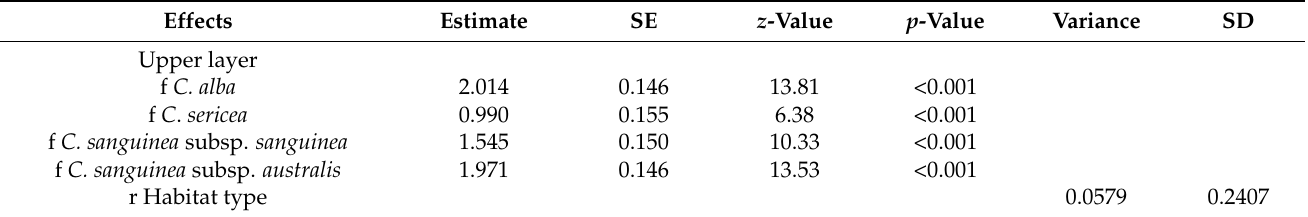
Table 7. GLMM results for the intact seed density in the upper (0–5 cm) soil layer. Taxa were consid- ered as a fixed effect (f) and the habitat type was considered as a random effect (r). SE—standard error; SD—standard deviation.